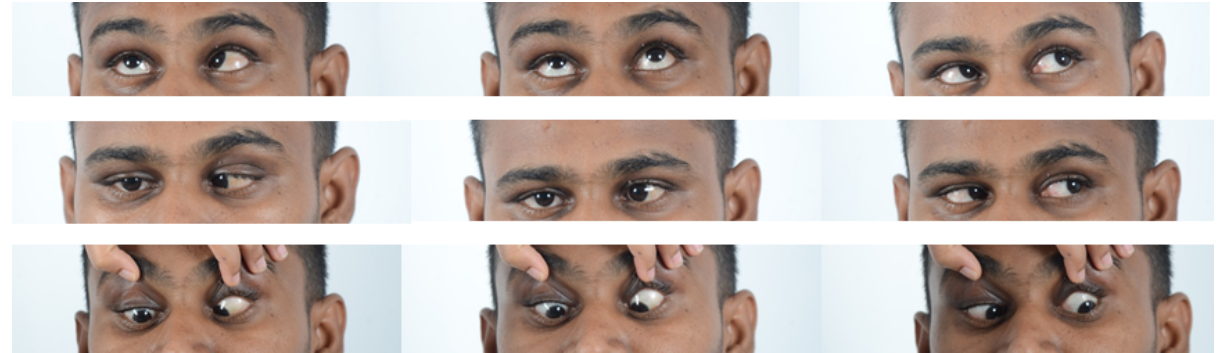
Figure 1: Ocular movements showing restricted abduction in the right eye